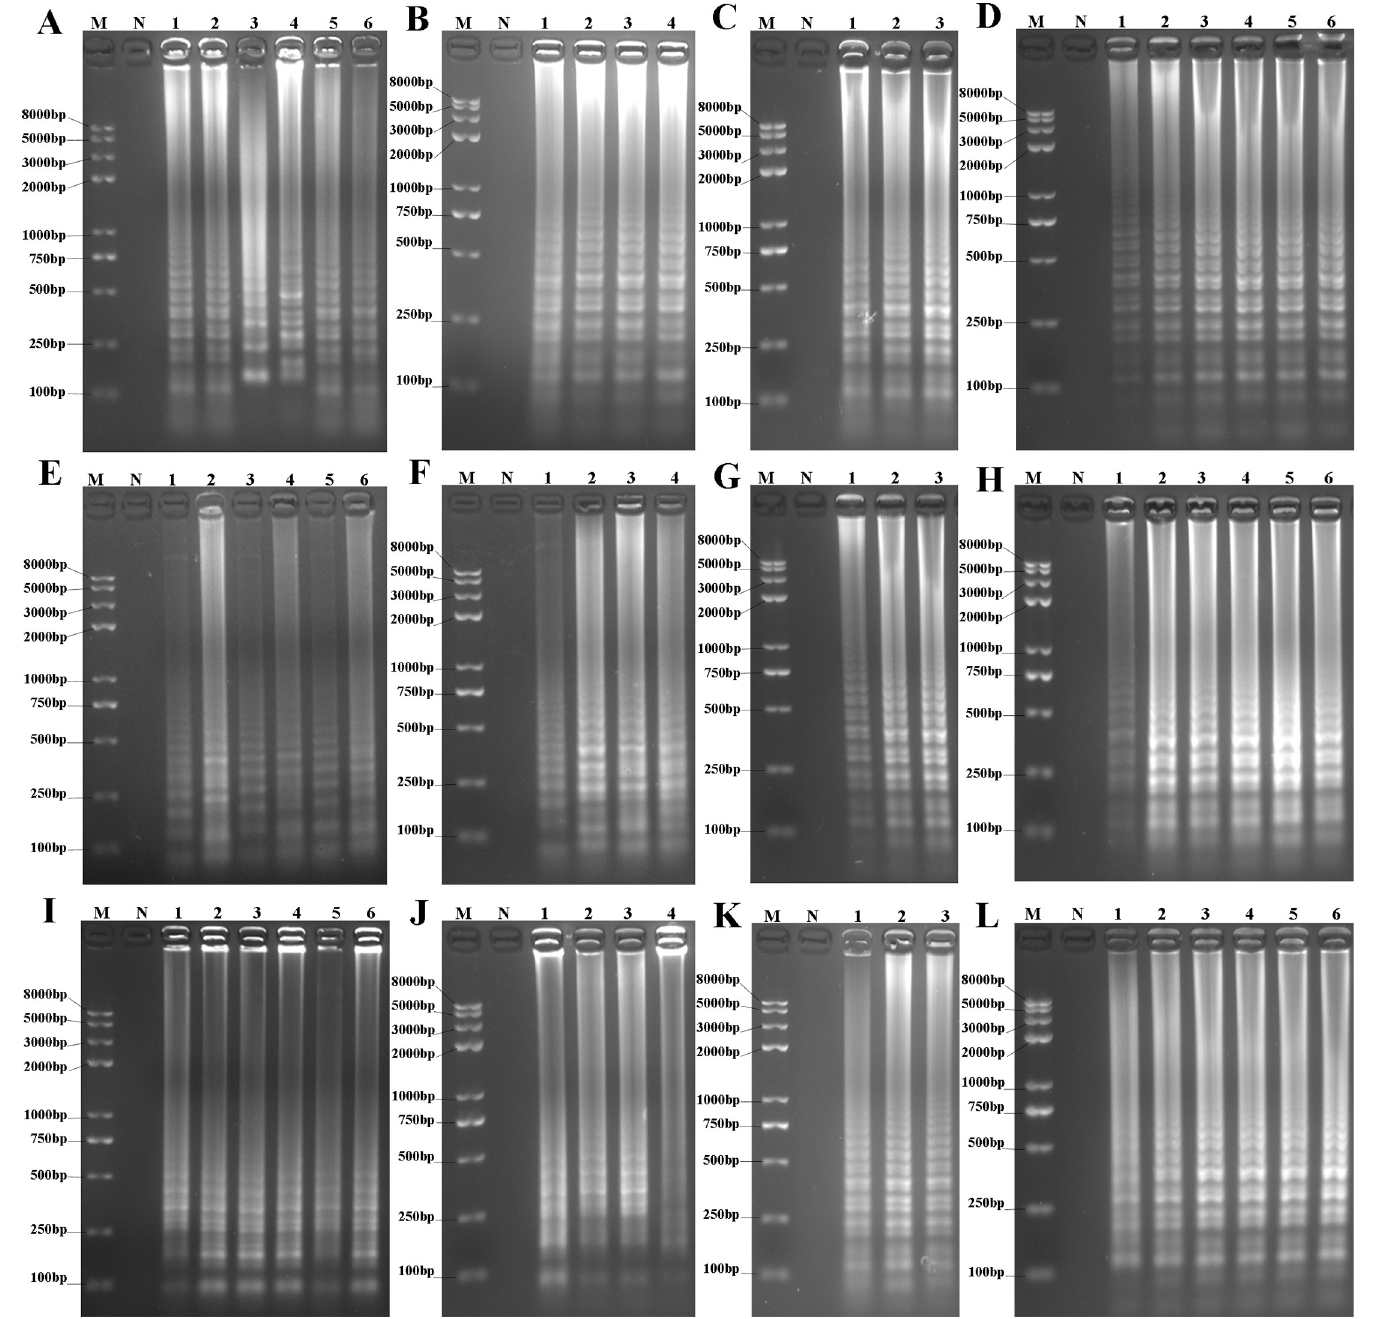
Fig 5. Optimization of various amplification conditions. A, E and I, Optimization of temperature for LAMP, CPA and IMSA, respectively. 1–6, Amplification products at 60, 62, 64, 66, 68 and 70˚C, respectively. B, F and J, Optimization of Bst DNA enzyme concentration for LAMP, CPA and IMSA, respectively. 1–4, Amplification products for Bst DNA enzyme concentrations at 6, 8, 10 and 12 U, respectively; C, G and K, Optimization of Mg 2+ concentration for LAMP, CPA and IMSA, respectively. 1–3, 1.0, 2.0 and 3.0 mM, respectively; D, H and L, Optimization of incubation time for LAMP, CPA and IMSA, respectively. 1–6, Amplification products at 30, 45, 60, 75, 90 and 120 min, respectively. M, Trans 2K plus II DNA marker; N, negative